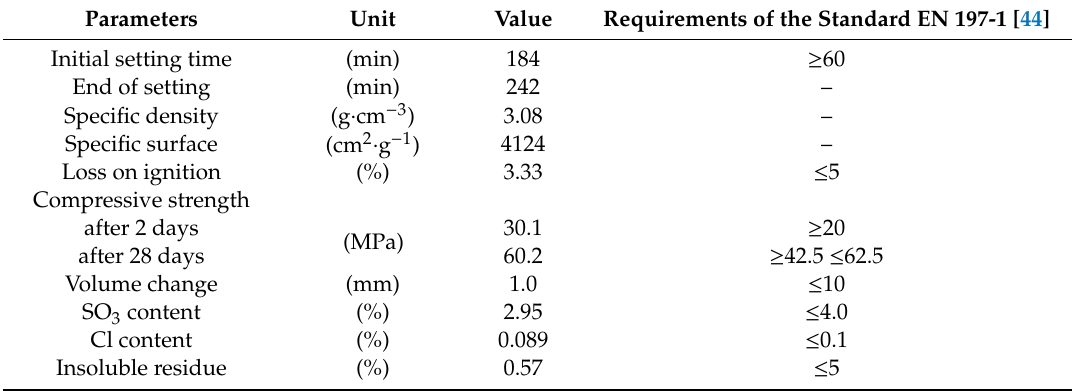
Table 3. Technical parameters of CEM I 42.5 R Portland cement (on the basis of the manufacturer’s information [45]).